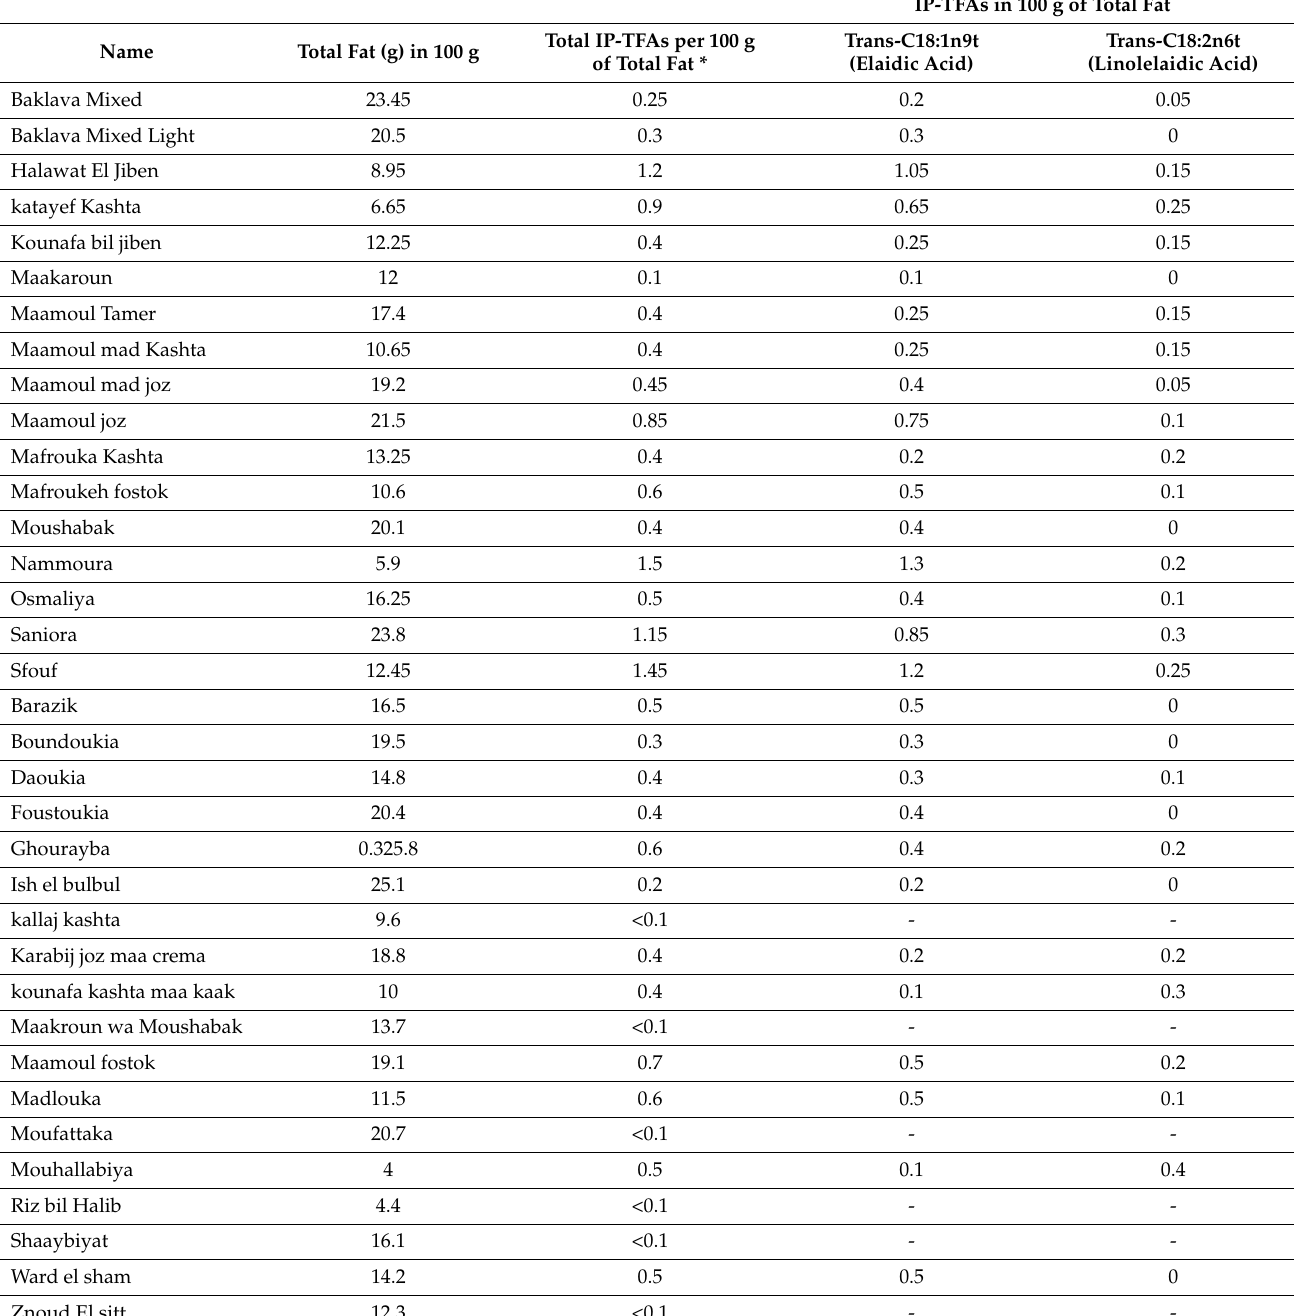
Table 2. Total fat in 100 g of edible portions, total IP-TFAs and IP-TFAs (EA and LEA) in 100 g of total fat of frequently consumed Arabic